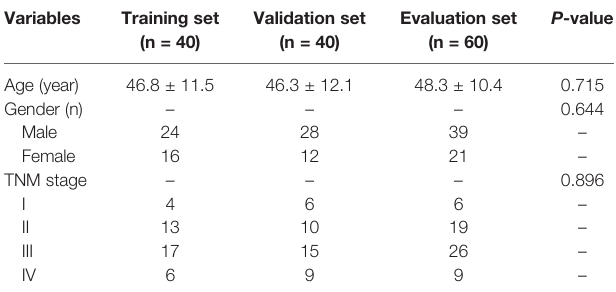
TABLE 1 | Pathological data of colon cancer patients in discovery, training and validation sets.